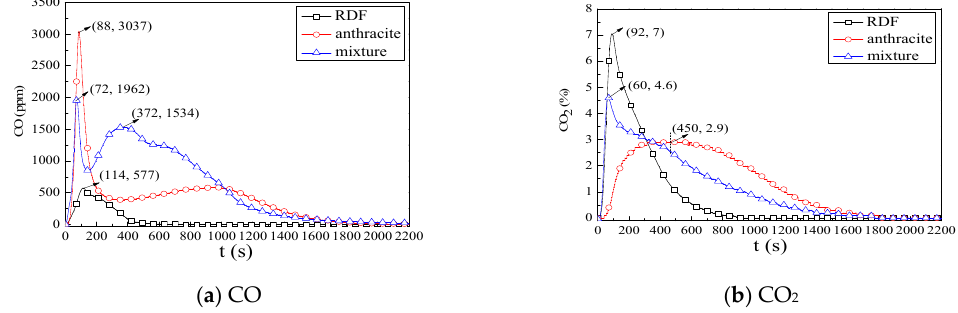
Figure 4. CO and CO 2 emission curves at 800 °C during combustion.